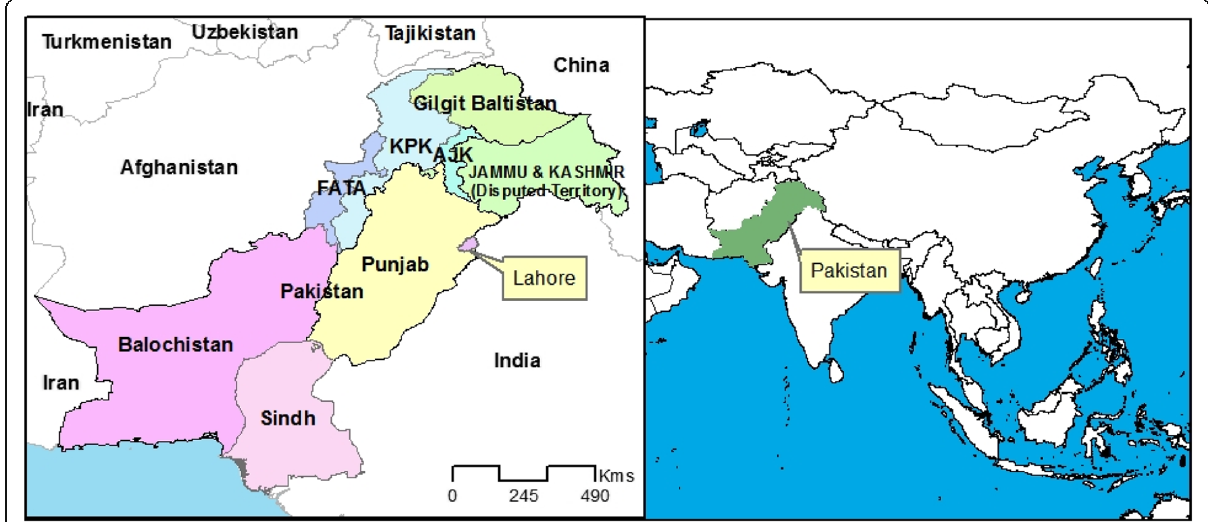
Fig. 1 Location map showing Lahore — the study